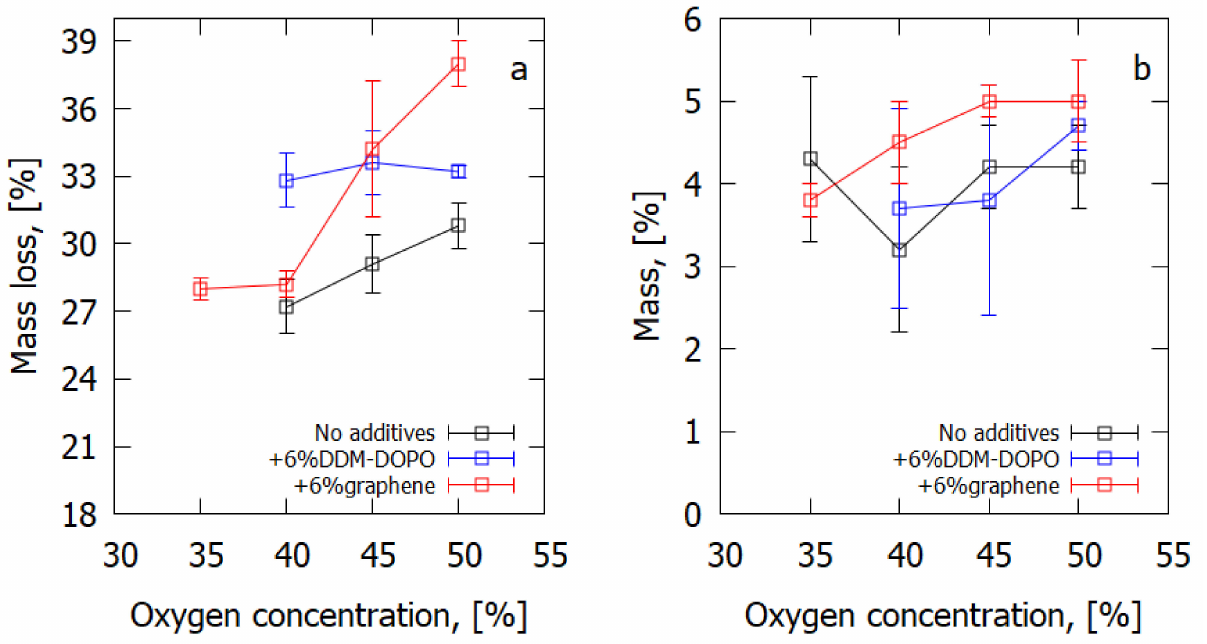
Figure 6. ( a ) Measured total mass loss of a sample after the experiment, and ( b ) the mass of soot collected from the sample surface after the